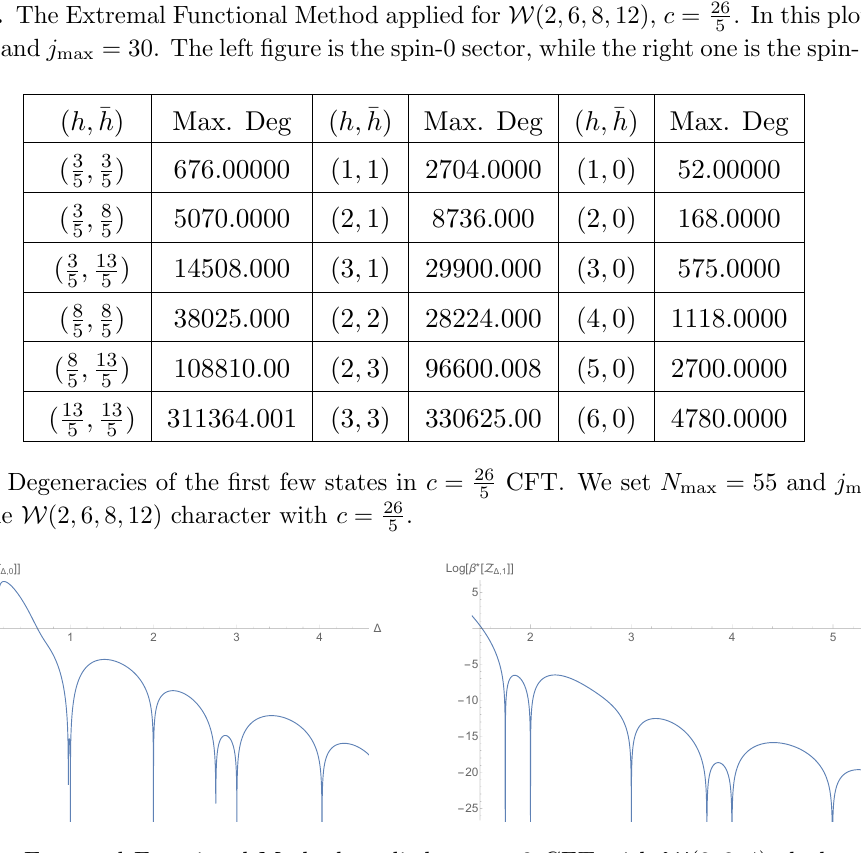
Figure 22. Extremal Functional Method applied to c = 3 CFT with W (2 ; 3 ; 4)-algebra. In this plot, we set N max = 51 and j max =